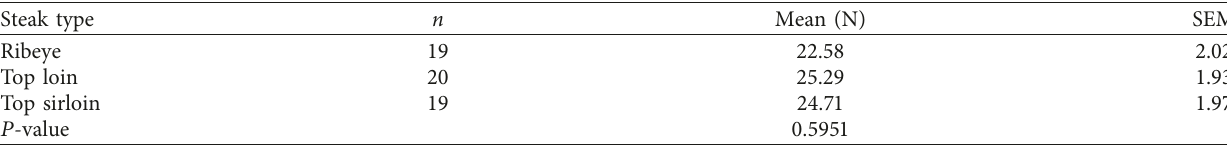
Table 7: Percentage distribution of Farmers Market steaks stratified into tenderness categories based on Belew et al. [16]. Steak type